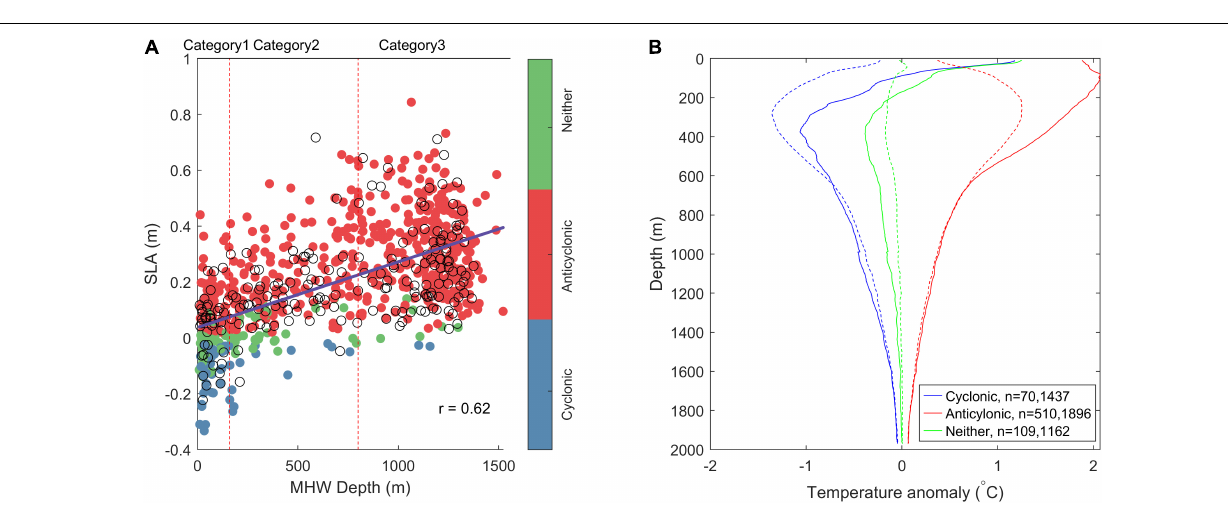
FIGURE 12 | (A) Scatter plot of sea level anomaly (SLA) and MHW depth. Colors indicate whether the water profile is in a cyclonic eddy (blue) an anticyclonic eddy (red) or not in an eddy (green). Hollow circles represent non-significant SLA. The regression line between SLA and MHW depth and correlation coefficient are indicated. Category thresholds are depicted by the top x -axis. (B) Mean temperature anomaly profiles per eddy type: cyclonic (blue line), anticyclonic (red line) and not in an eddy (green line) averaged for MHW (solid) and NoMHW (dashed) Argo floats. Number of profiles per category are indicated in the legend for MHWs and NoMHWs,